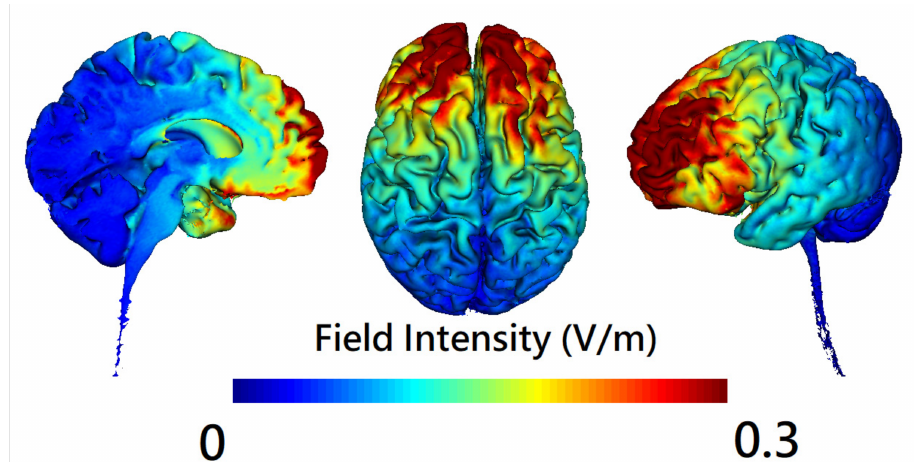
Figure 2. The modeling of electric field distribution of high-definition high-frequency transcranial random noise stimulation (hf-tRNS) over the lateral prefrontal cortex. The figure was created using HD-Explore ® software (Soterix Medical, New York, NY,